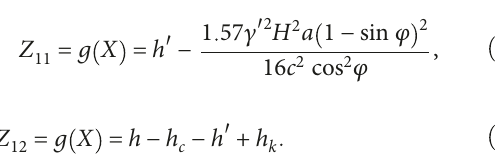
x . (b) Distribution diagram of